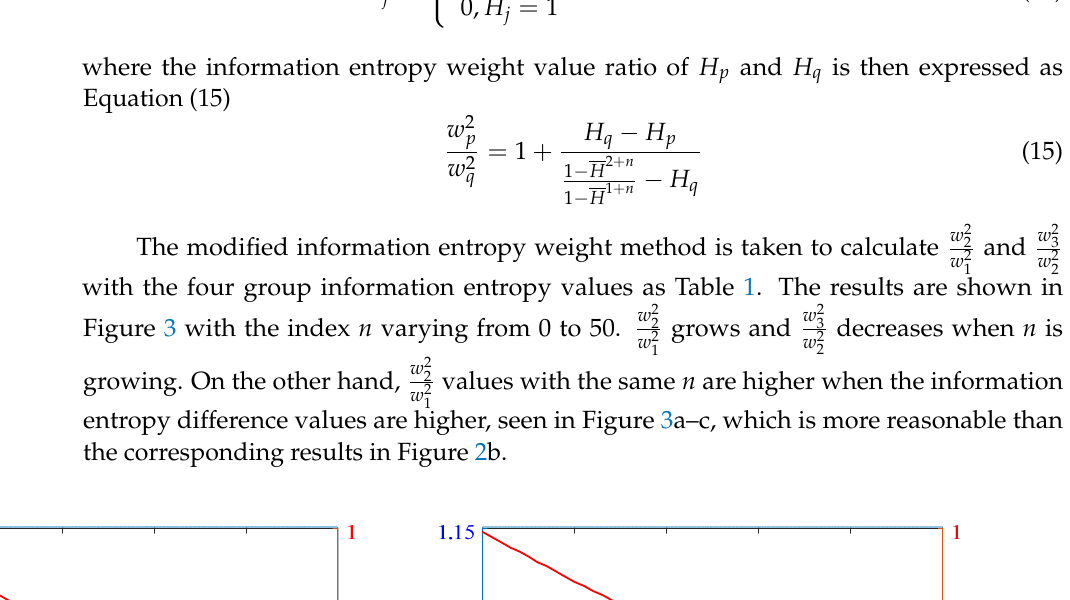
2 2 2 Figure 3. ( a ) w and w varying by different n values in group 1. ( b ) w 3 2 w 2 1 w 2 2 2 varying by different n values in Figure 3. ( a ) 2 2 ( c ) w and w varying by different n values in group 3. ( d ) w 3 2 w 2 1 w 2 2